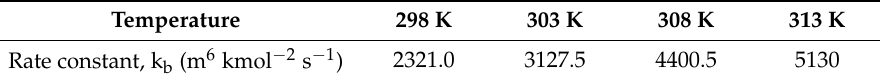
Table 4. Reaction rate constants at different temperatures using Zwitterion